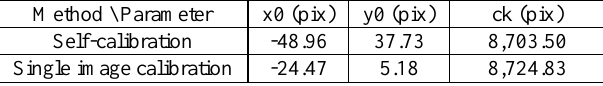
Table 2. The comparison of camera interior orientation elements calculation results performed with two methods.